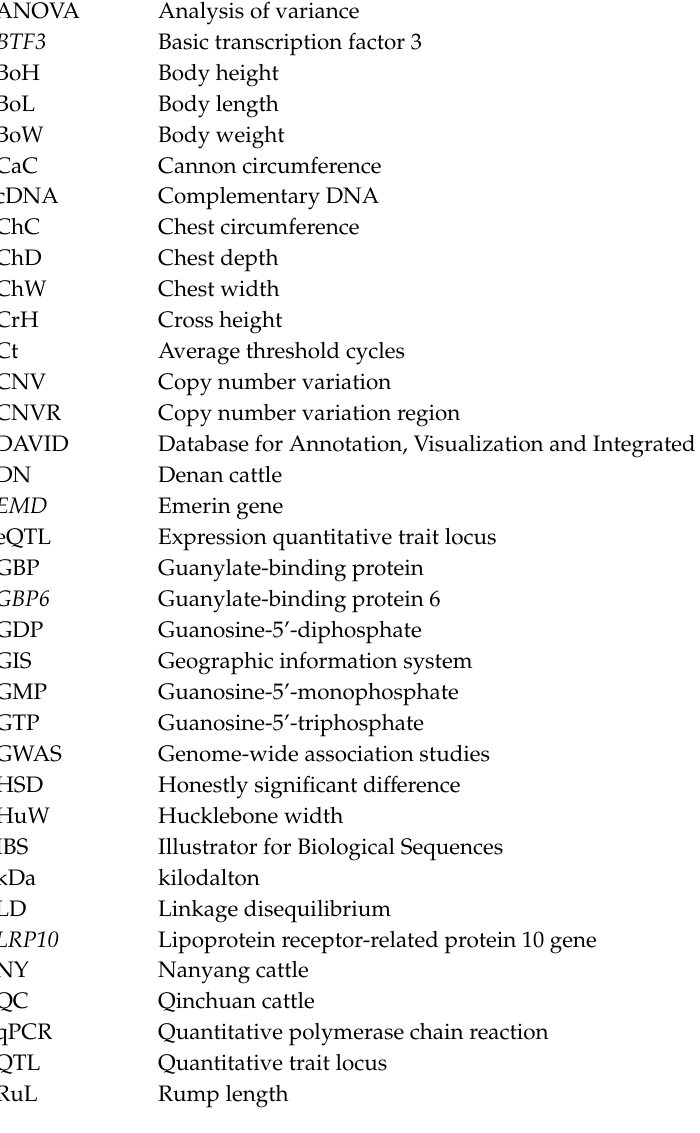
Table S1: Relative expression values of GBP6 in seven tissues of QC and XN cattle in fetal, calve and adult stages with three